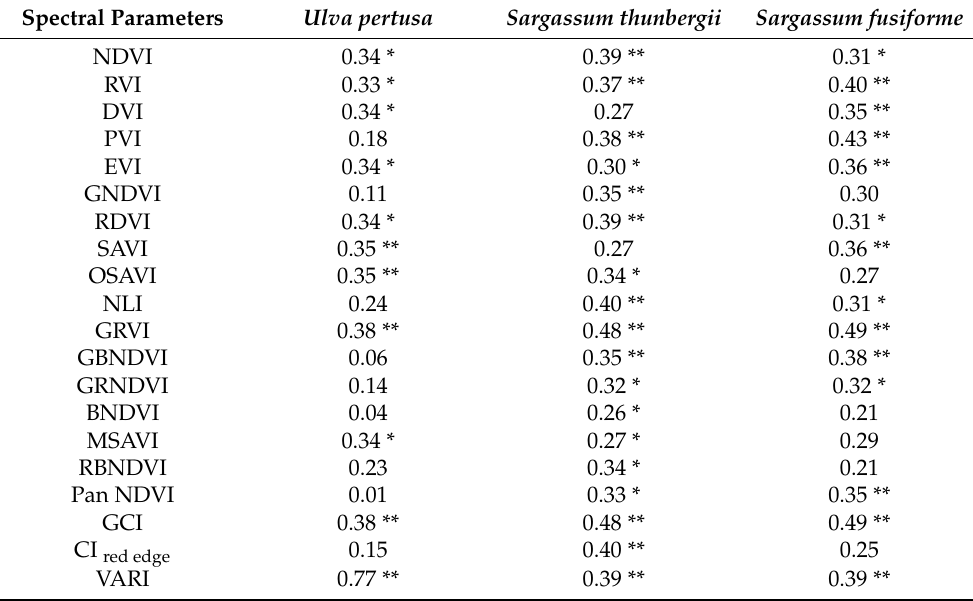
Table 3. Pearson’s correlation coefficients between improved vegetation index and biomass. Spectral